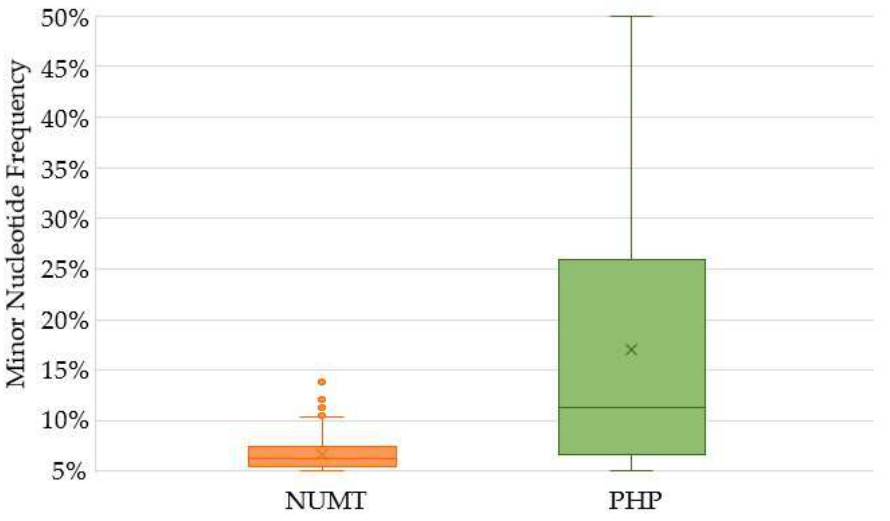
(Table 2). The remaining 420 mixed positions could not be associated with a NUMT and were therefore classified as probable PHPs (Table S1).